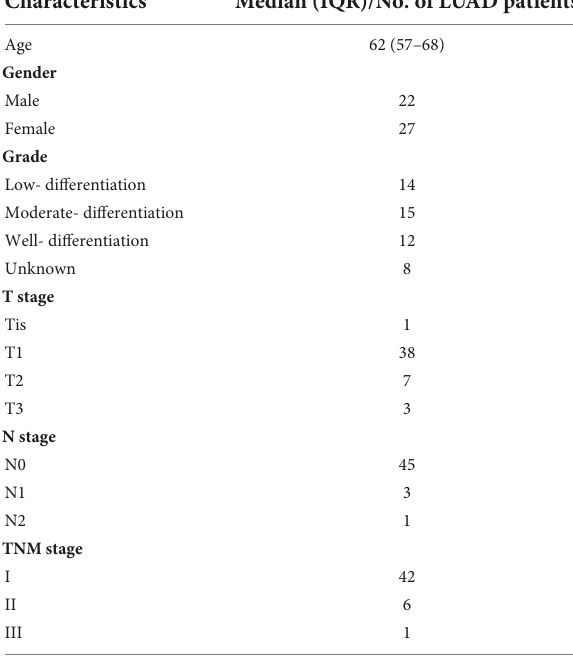
TABLE 1 Clinical characteristics of 49 LUAD patients. Characteristics